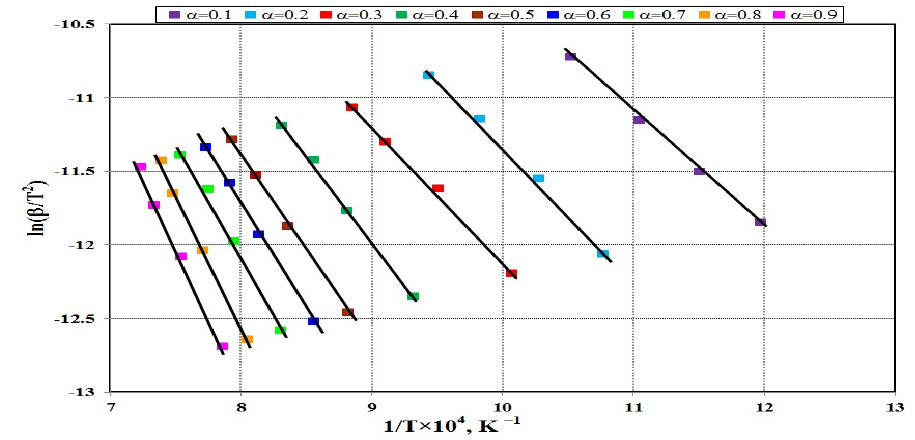
Figure 8. Kissinger plot of Fe 2 O 3 /coal composites at different conversion degrees ( α ). Table 4. Apparent activation energy values computed at overall reduction reaction.